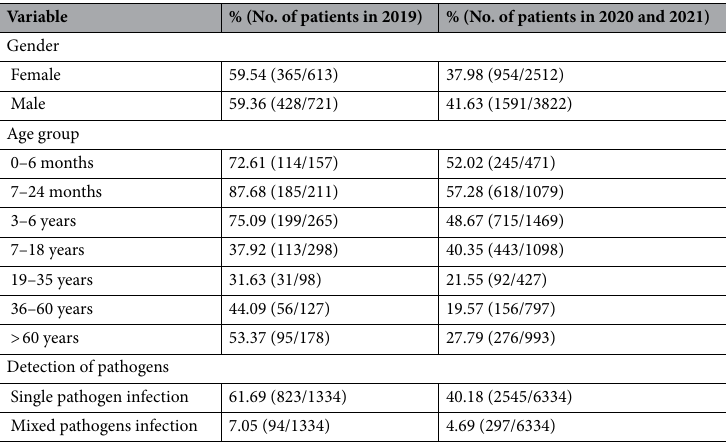
Table 1. Demographic, clinical data of patients enrolled before and after